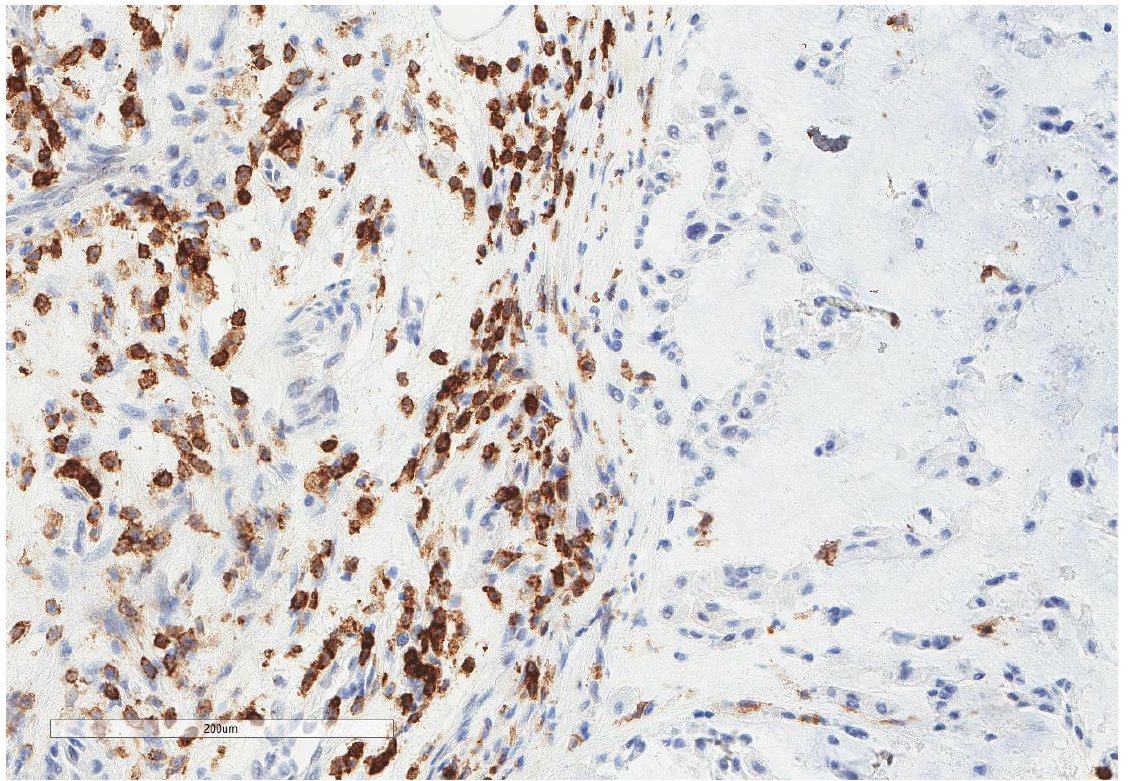
Figure 3. Representative microscopic image (×200 magnification) of high CD4 expression. The right part of the image shows the tumor, and the left part shows the inflammatory cells.